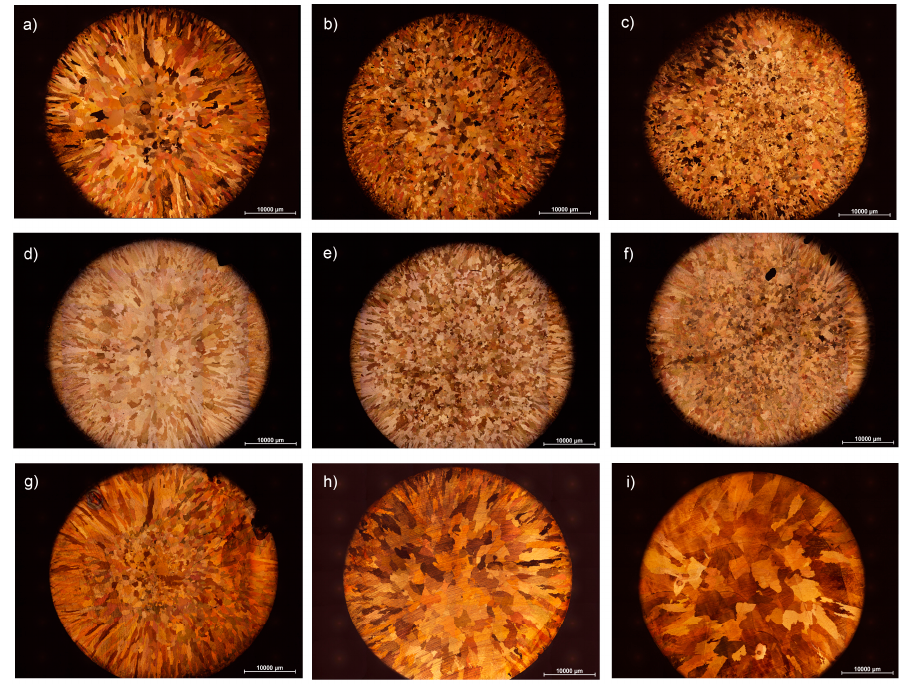
Figure 7. Macrographs of Cu–Ni, Cu–Bi and Cu–Cr alloys. ( a ) 0.011 wt % Ni, ( b ) 0.241 wt % Ni, ( c ) 0.949 wt % Ni, ( d ) 0.036 wt % Bi, ( e ) 0.176 wt % Bi, ( f ) 0.248 wt % Bi, ( g ) 0.001 wt % Cr, ( h ) 0.389 wt % Cr, and ( i ) 0.786 wt % Cr. Macrographs ( b ) and ( c ) are reprinted with permission from [32], Taylor and Francis Ltd., 2017.